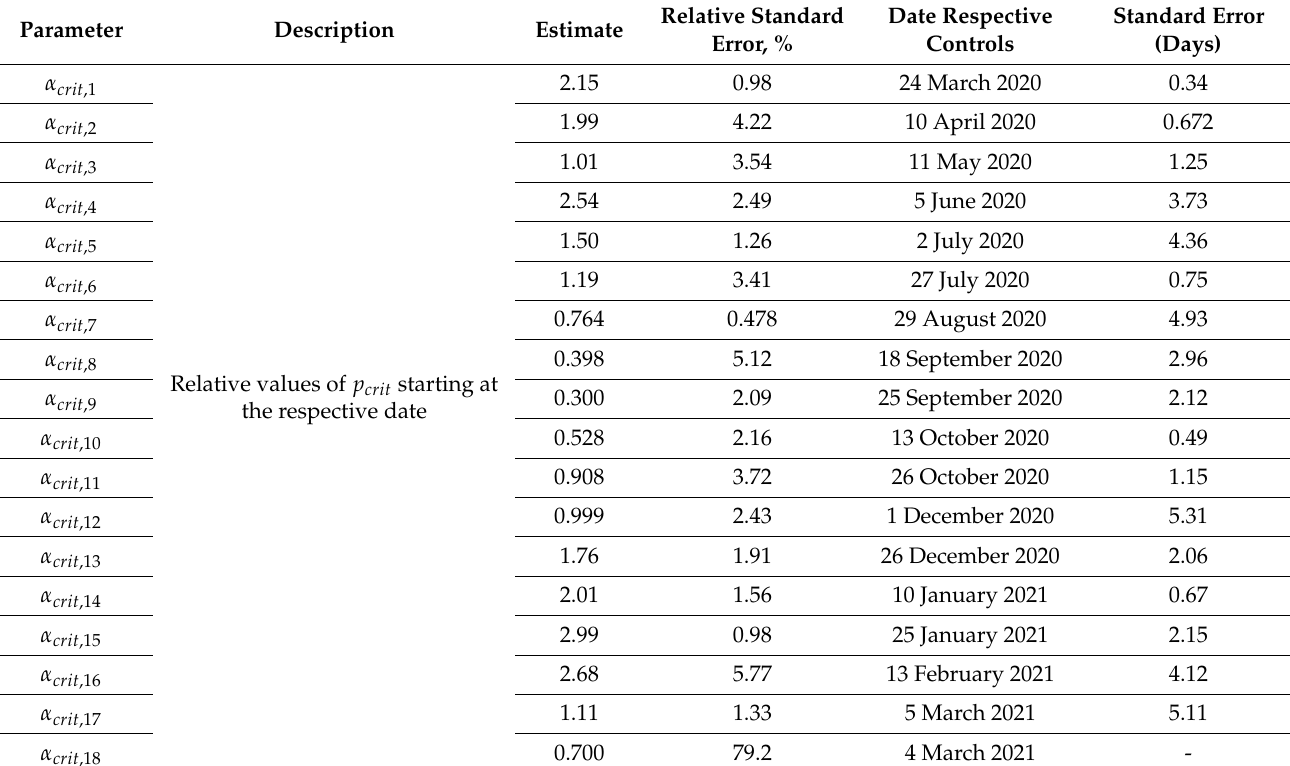
Table A7. Step functions of p crit and p death for Saxony. We present estimates for the steps of the functions p crit and p death at the specified dates and respective standard errors for Saxony. We also provide the standard error of the estimated time point (last